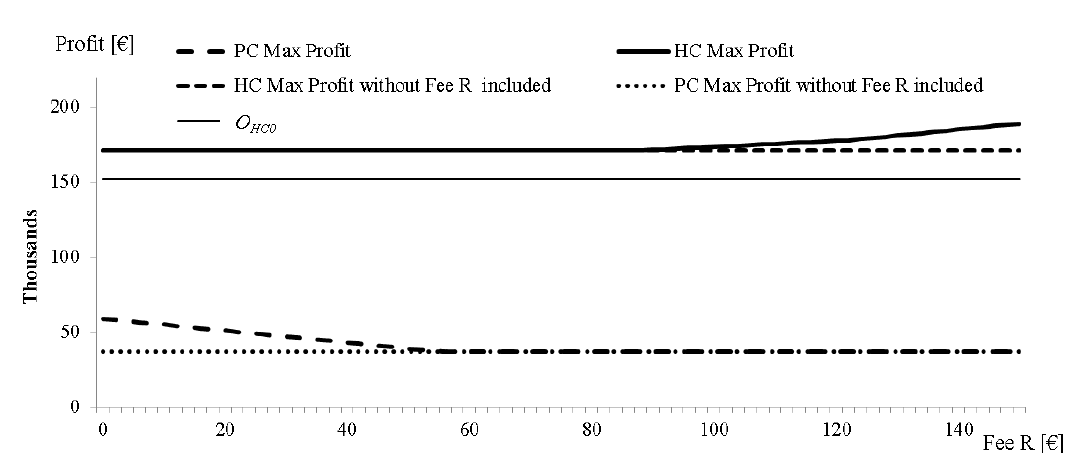
Figure 11. Fee R impacts on PC/HC profit in Scenario